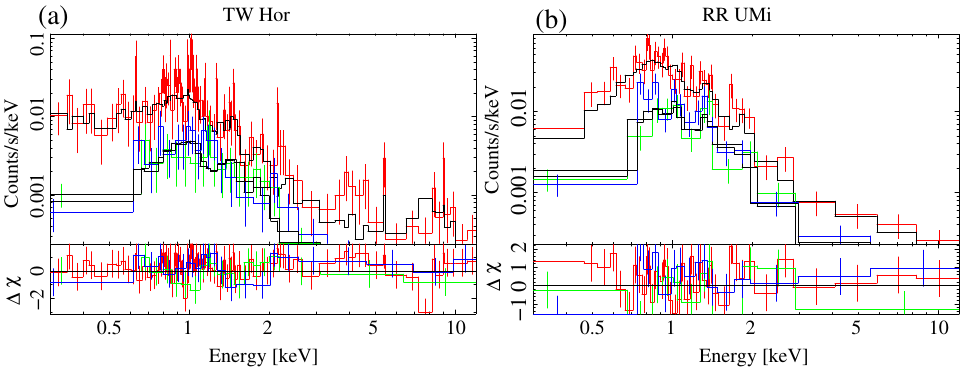
Figure 7. ( a ) X-ray spectra (EPIC/XMM) ( colored curves ) and APEC model fits ( black curves ) for ( a ) the nuvAGB star TWHor, and ( b ) the fuvAGB star RRUMi. Bottom panel shows